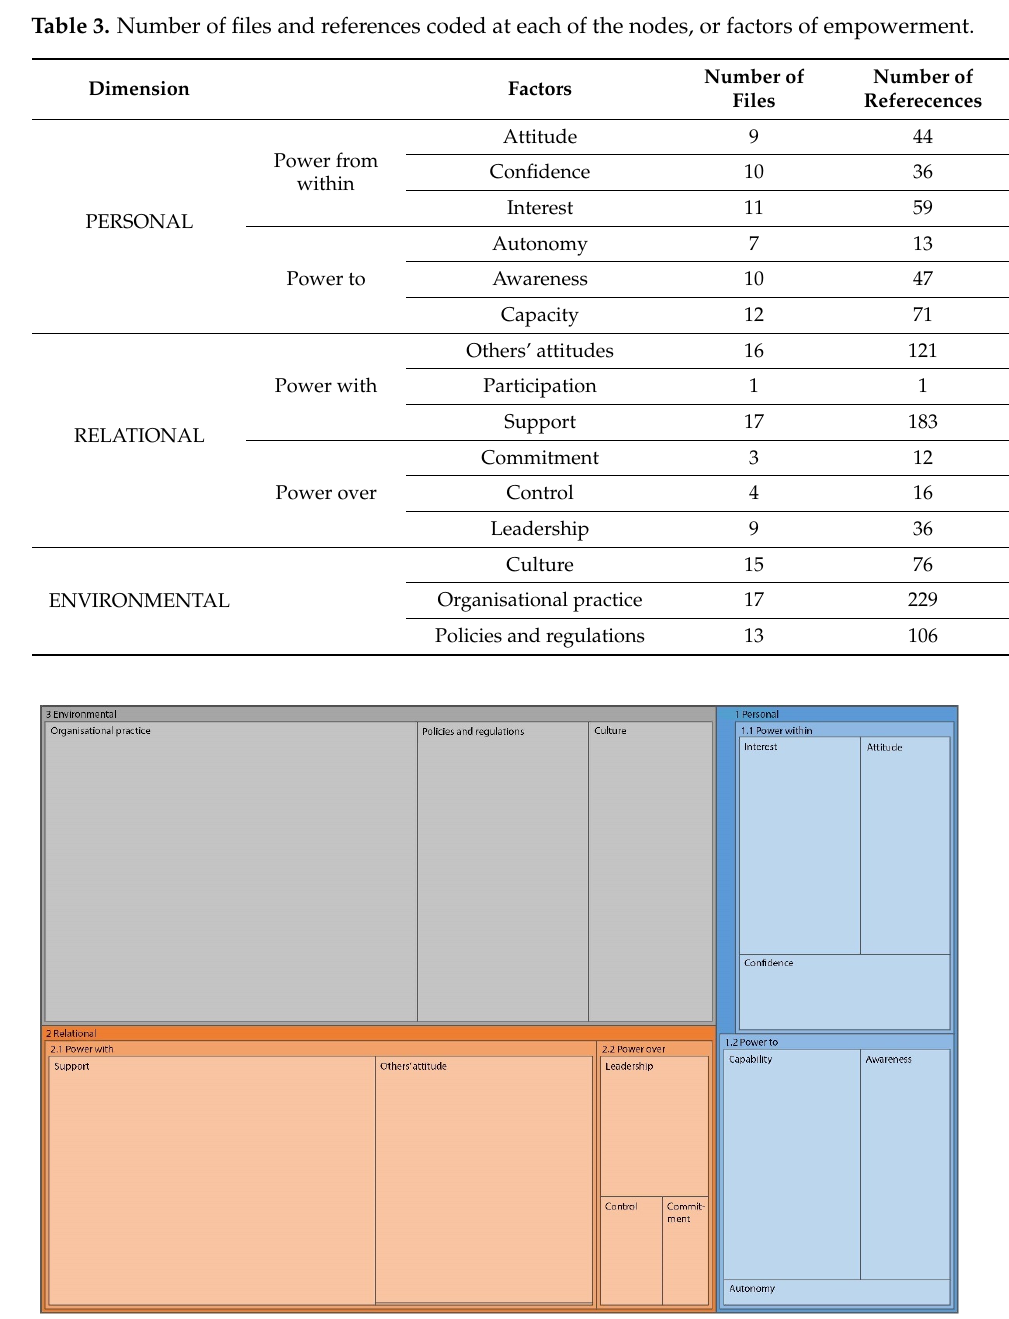
Figure 3. Hierarchy of nodes produced in Nvivo, illustrating the predominance of discussions under larger